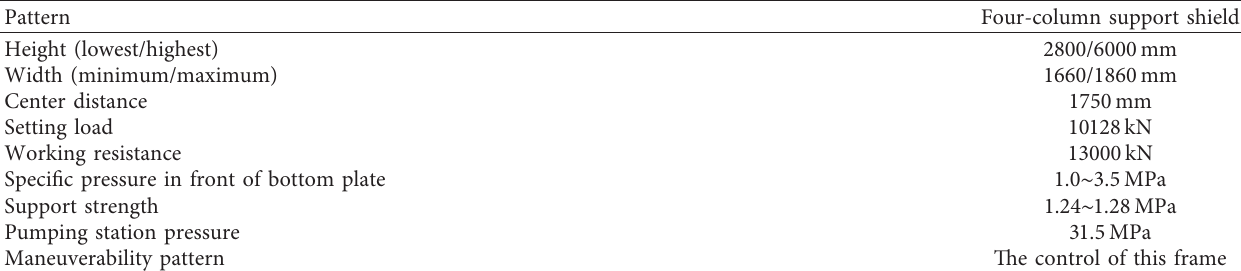
Table 7: The main support technical parameters of the ZZ13000/28/60.